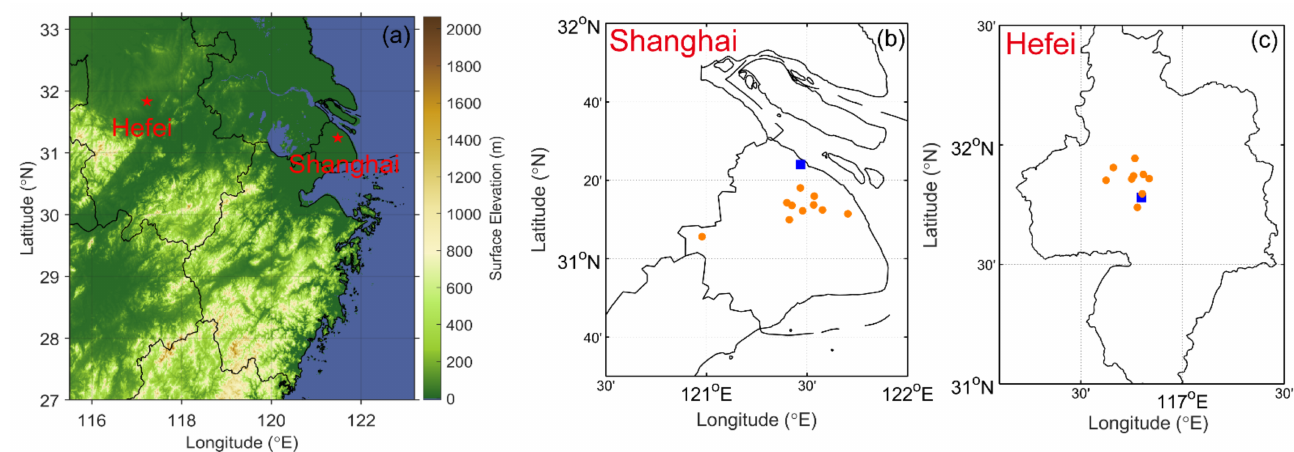
Figure 1. ( a ) Map showing the locations of Hefei and Shanghai in the Yangtze River Delta (YRD) and the locations of air quality (orange circles) and meteorological (blue squares) stations in ( b ) Shanghai and ( c )